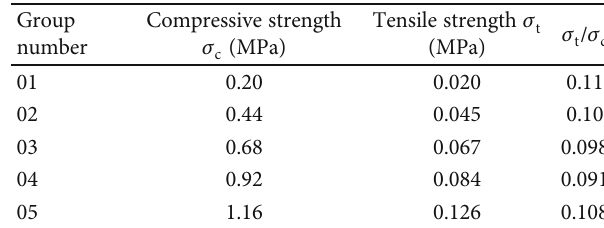
Figure 4: Typical failure modes of samples. Table 3: Tensile strength values of some test blocks.